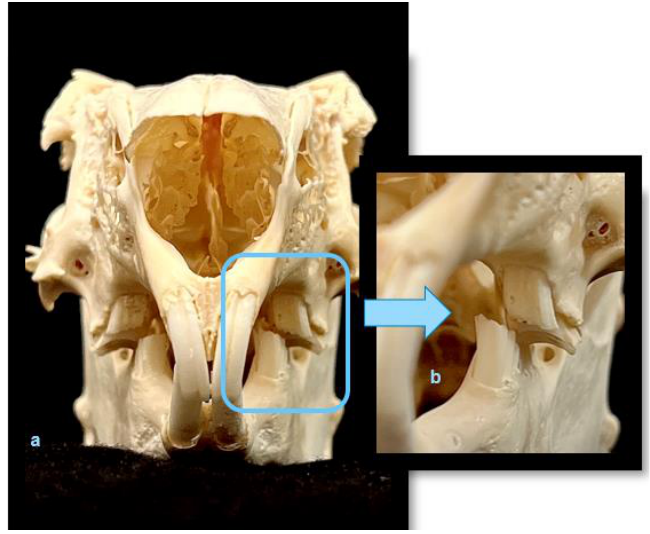
Figure 4. Anisognathism in rabbits: in 1:1 scale ( a ), enlarged ( b ) (by Małgorzata Peruga and Jakub Kotowicz).